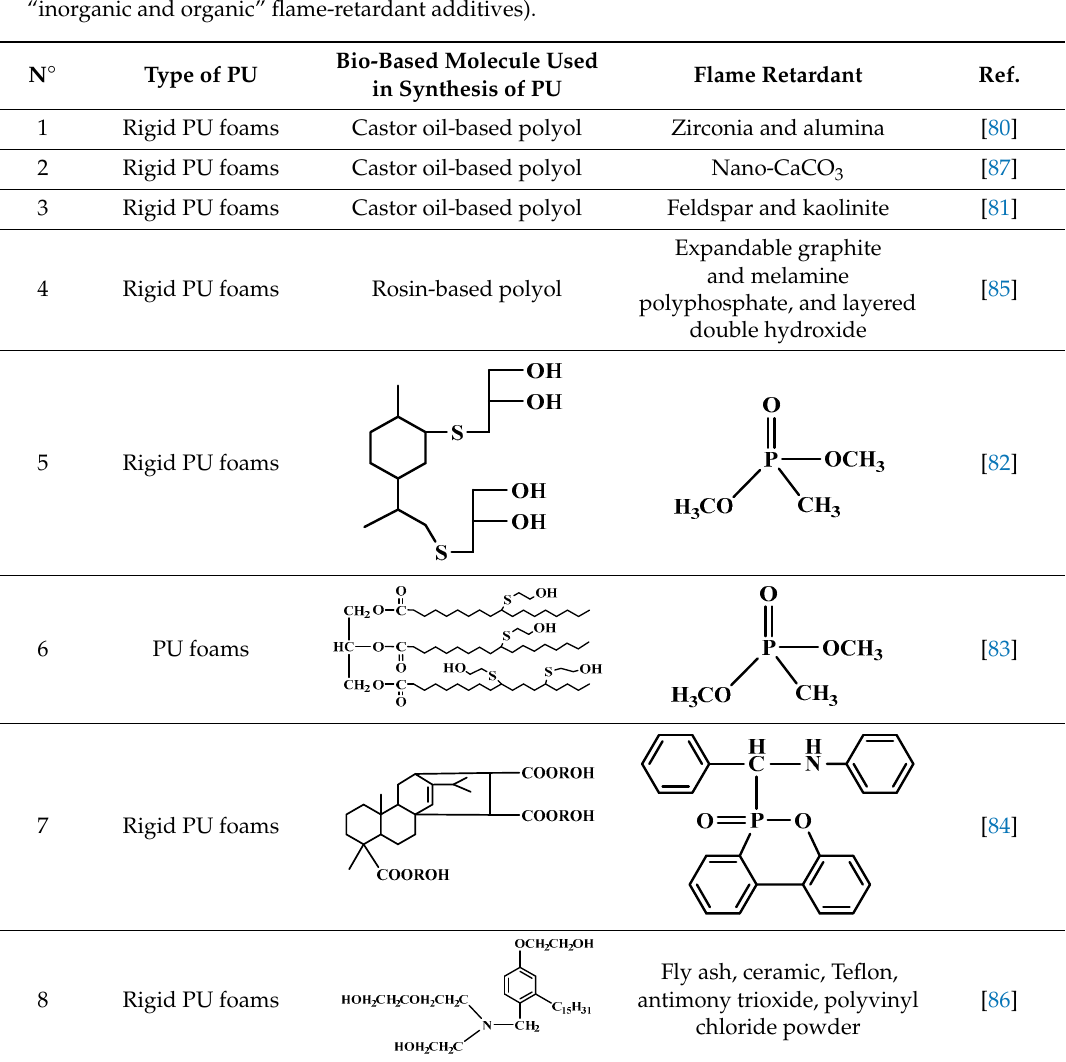
Table 2. Summary of “additive” flame-retardant bio-based PUs (Numbers 1 to 4 correspond to the “inorganic”, while numbers 5 to 7 correspond to the “organic”, and number 8 corresponds to both “inorganic and organic” flame-retardant additives).